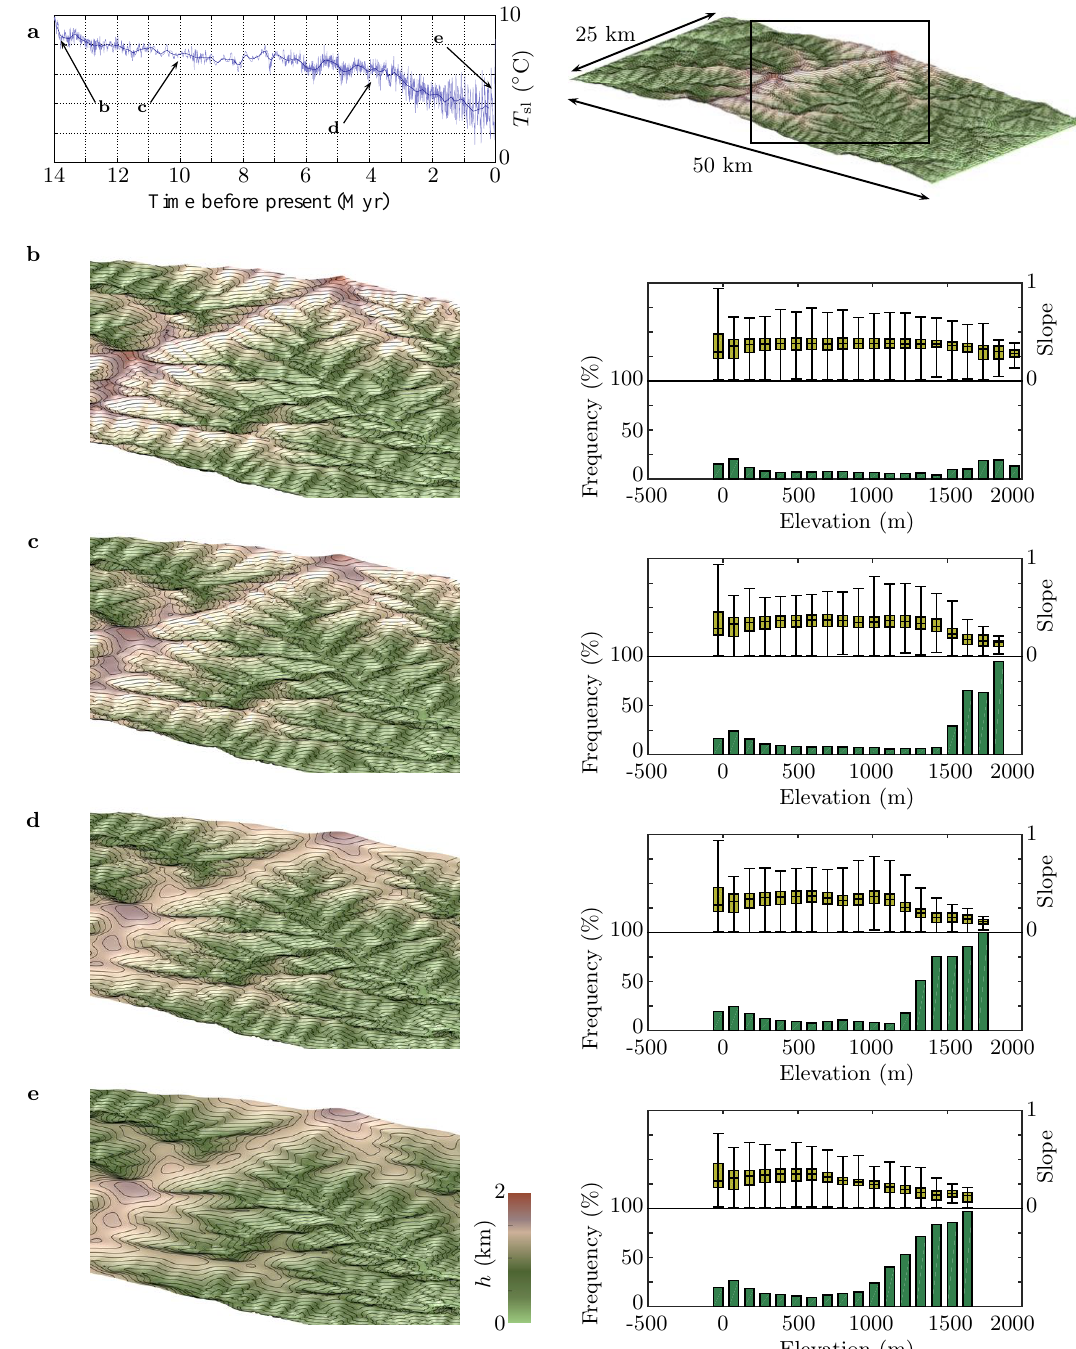
Figure 10. Computational experiment (no. 2) based on a landscape with kilometre-scale relief. Panel (a) : the 14Myr temperature curve used as input for the model (left), and the initial topography (right). Panels (b–e) : topographic evolution (left panel) and elevation–slope relations (right panel) after 0, 4, 10, and 14Myr, respectively. To magnify the detail, topography is only shown for a selected region, as outlined by the black rectangle in the right panel of (a) . The elevation–slope diagrams each have two sections: upper section shows the distribution of surface slope as box-and-whisker plots for different elevation intervals; lower section shows the frequency of flat regions (slope < 0 . 1) at the different elevations. Over time, the highest parts of the landscape are smoothed significantly and summit flats are formed at several levels above 1000m. The formation of summit flats is accompanied by a distinct decrease in surface slope in the highest part of the landscape, and above 1500m almost 100% of the landscape has surface slopes less than 0.1. The smoothing starts at elevations above 1500m (c) , but spreads to elevations above 1000m as the climate cools further during the last interval mimicking the Quaternary (d, e) .